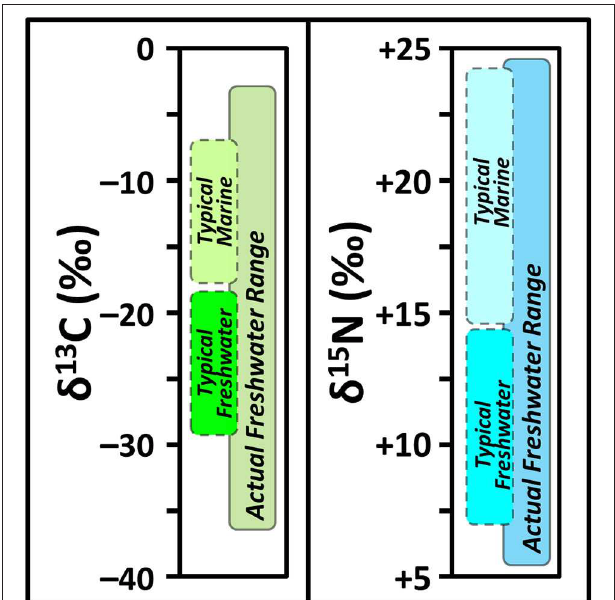
FIGURE 2 | Generalized schematic showing the range of δ 13 C (left) and δ 15 N (right) that is typically anticipated for fish bone collagen during archaeological paleodietary interpretations compared to the ranges observed more broadly for fish collagen across the ecological literature (e.g., Dufour et al., 1999; Electronic Supplementary Information 1 ; Miller et al., 2010; Guiry et al.,